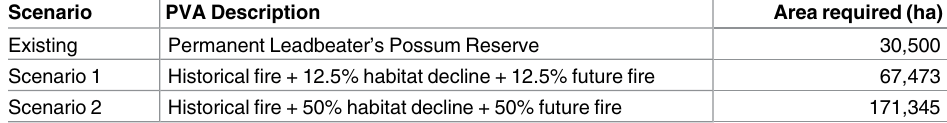
Table 2. The area of Leadbeater’s Possum Habitat required for a < 5% chance of population decline below 500 females under varying scenarios of habitat decline and future fire impact in the